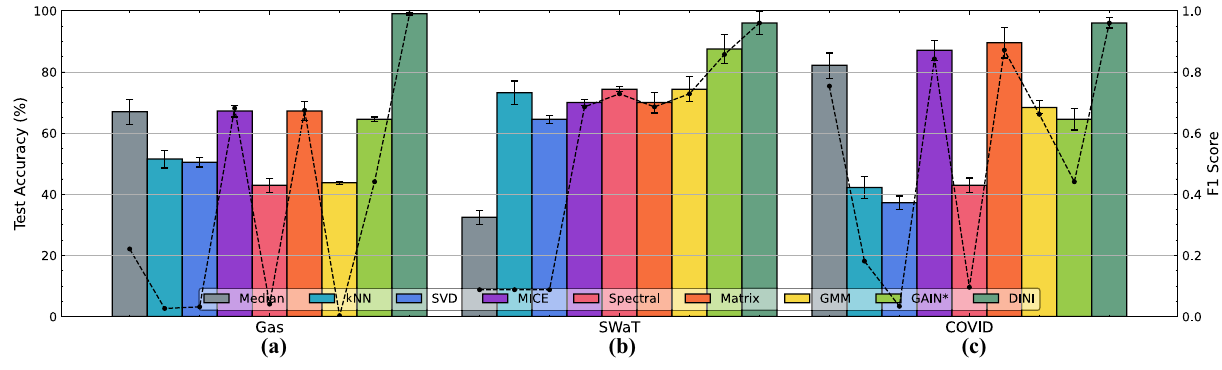
Figure 2. Test accuracy and F1 score for imputation models on the ( a ) Gas, ( b ) SWaT, and ( c ) COVID datasets, for the MSAR corruption strategy. Test accuracy is shown as bar plots with the axis on the left. F1 score is shown as a dashed line plot with the axis on the right.